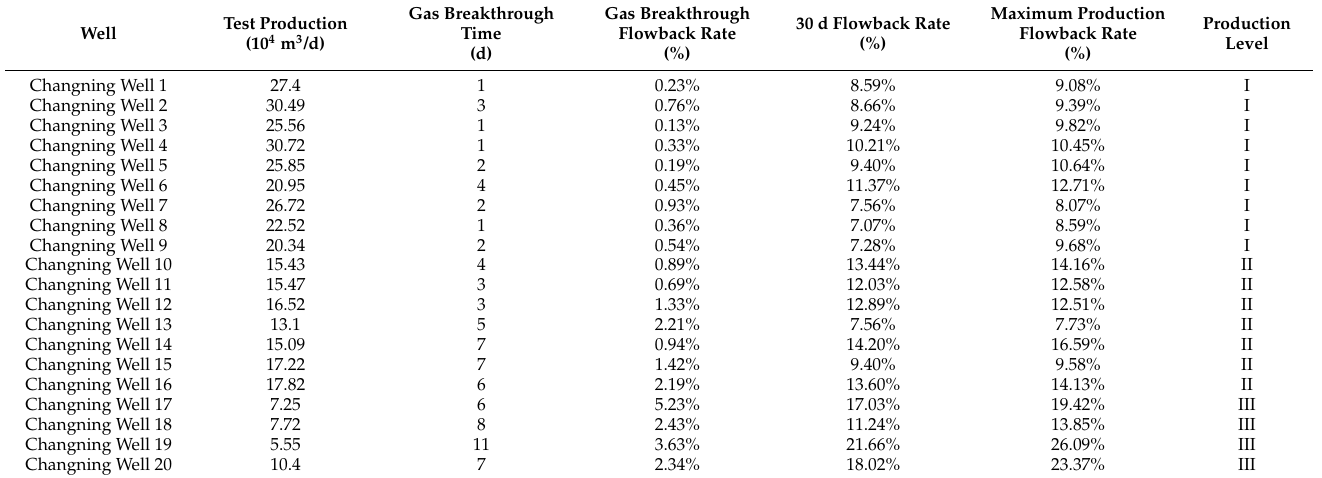
Table 2. Correspondence table between flowback characteristic parameters and test production of Changning typical shale gas wells.